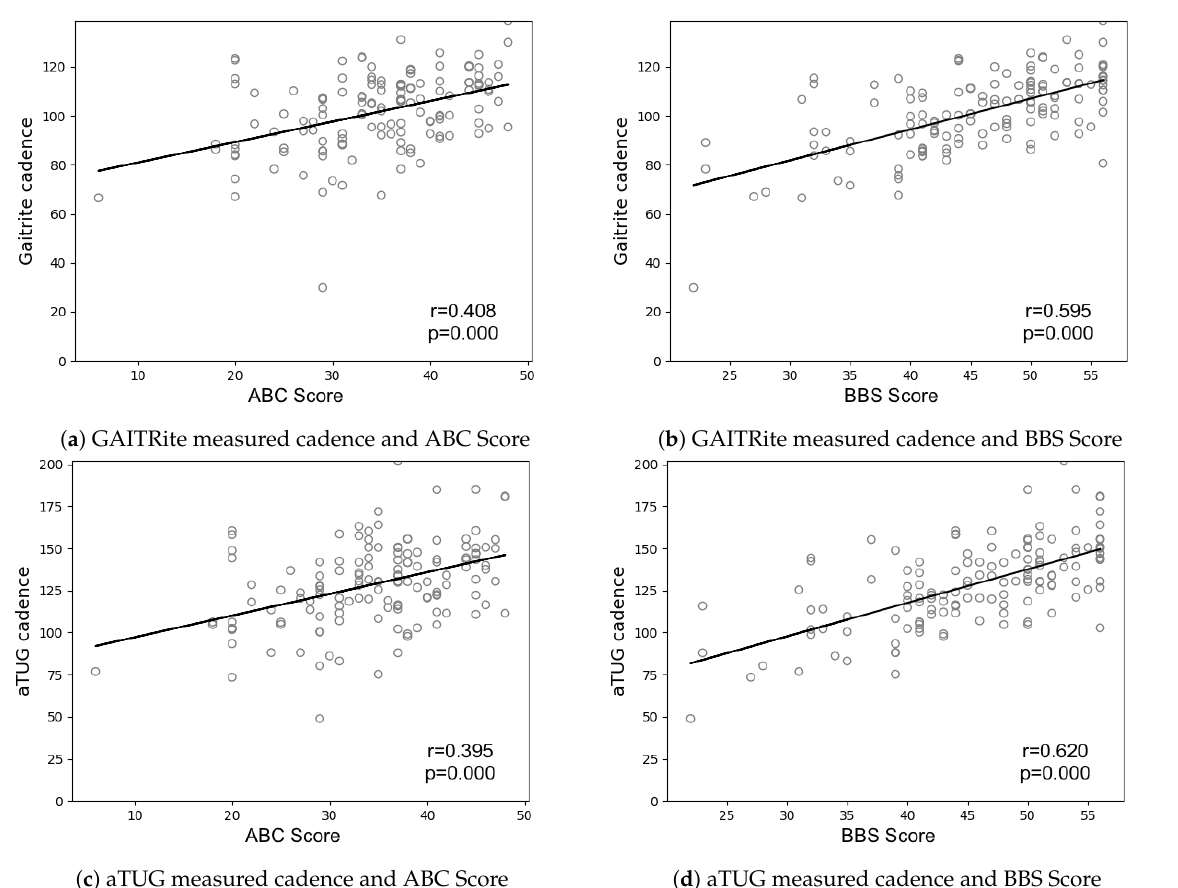
Figure 4. Scatterplot distribution among